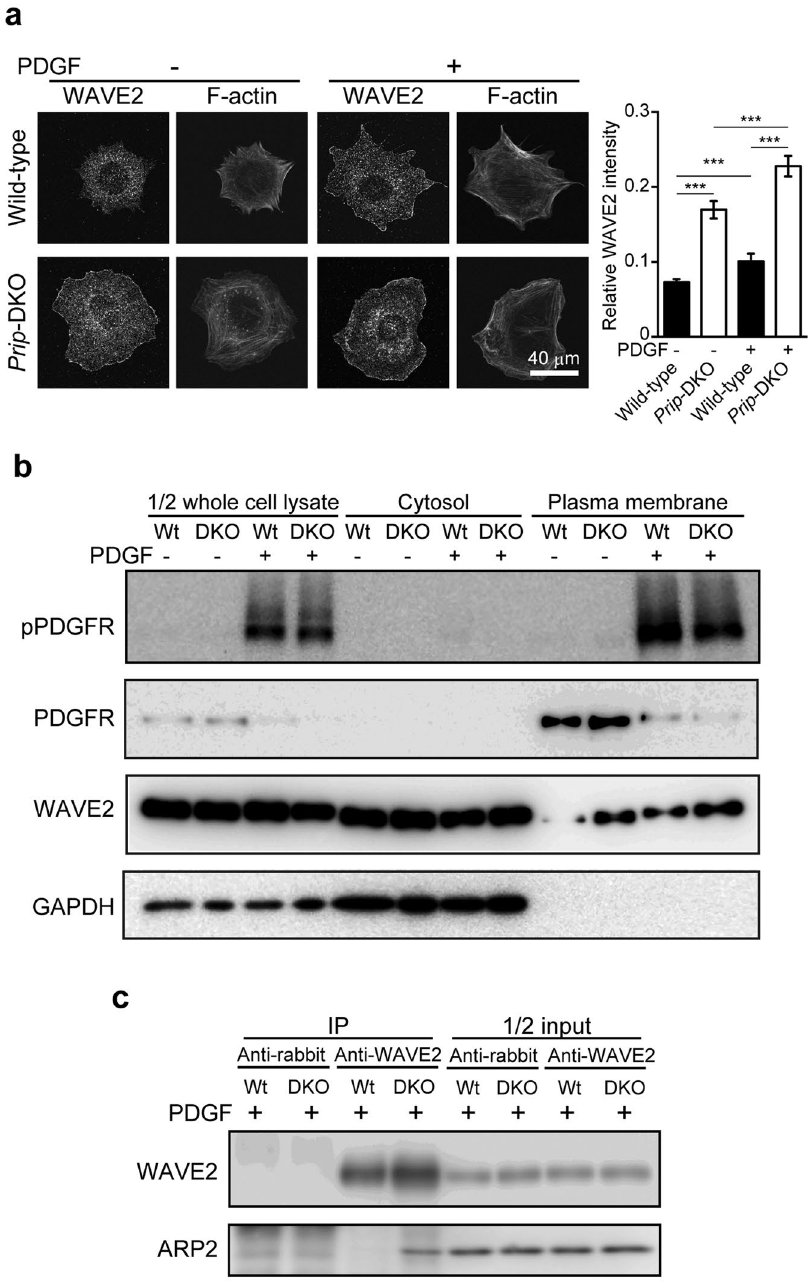
Figure 6. Alteration of PI(3,4,5)P 3 -mediated downstream signalling. ( a – c ) MEFs were stimulated with ( + ) or without ( − ) 20 ng/mL PDGF for 10 min. Cells were evaluated by immunocytochemistry using an anti-WAVE2 antibody and Alexa Fluor 350 phalloidin ( a ), cell fractionation assay by centrifugation ( b ), and immunoprecipitation (IP) assay using an anti-WAVE2 antibody ( c ). All experiments were performed at least three times independently, and similar data were obtained. Representative images are shown ( a – c ). The graph in ( a ) shows the fluorescence intensity of WAVE2 on the plasma membrane normalised by the intensity for the whole cell. The data are presented as means ± SEM [n = 39, 24, 34, and 24 in the left-to-right direction on the graph ( a )]. *** p < 0.001 between the indicated bars (Kruskal–Wallis test followed by Dunn’s multiple comparison test). The detection of GAPDH and PDGFR in ( b ) represents a quality assessment of the